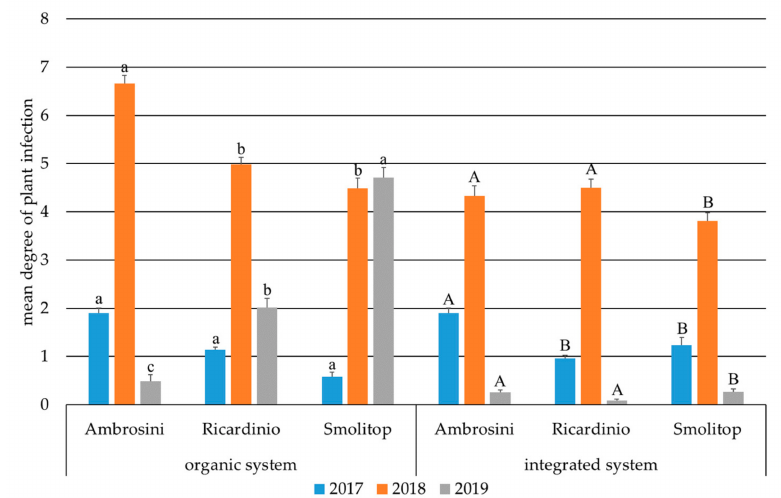
Figure 2. Plant infestation (mean ± SEM) with eyespot of three maize varieties in the years 2017–2019 in two cultivation systems; different letters denote significant differences among varieties (Ambrosini, Ricardinio, Smolitop) in the same year for organic (lowercase letters) and integrated (capital letters) farming, according to the Kruskal–Wallis test at p ≤ 0.05.